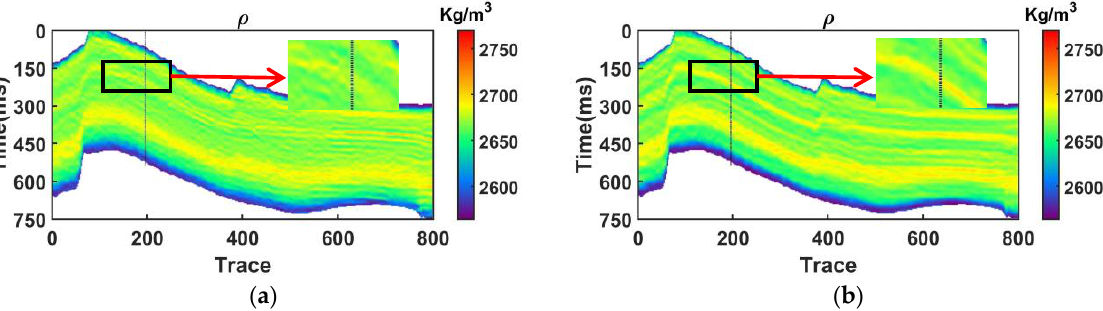
Figure 30. Density inversion results based on ( a ) traditional method and ( b ) reweighted Lp method.